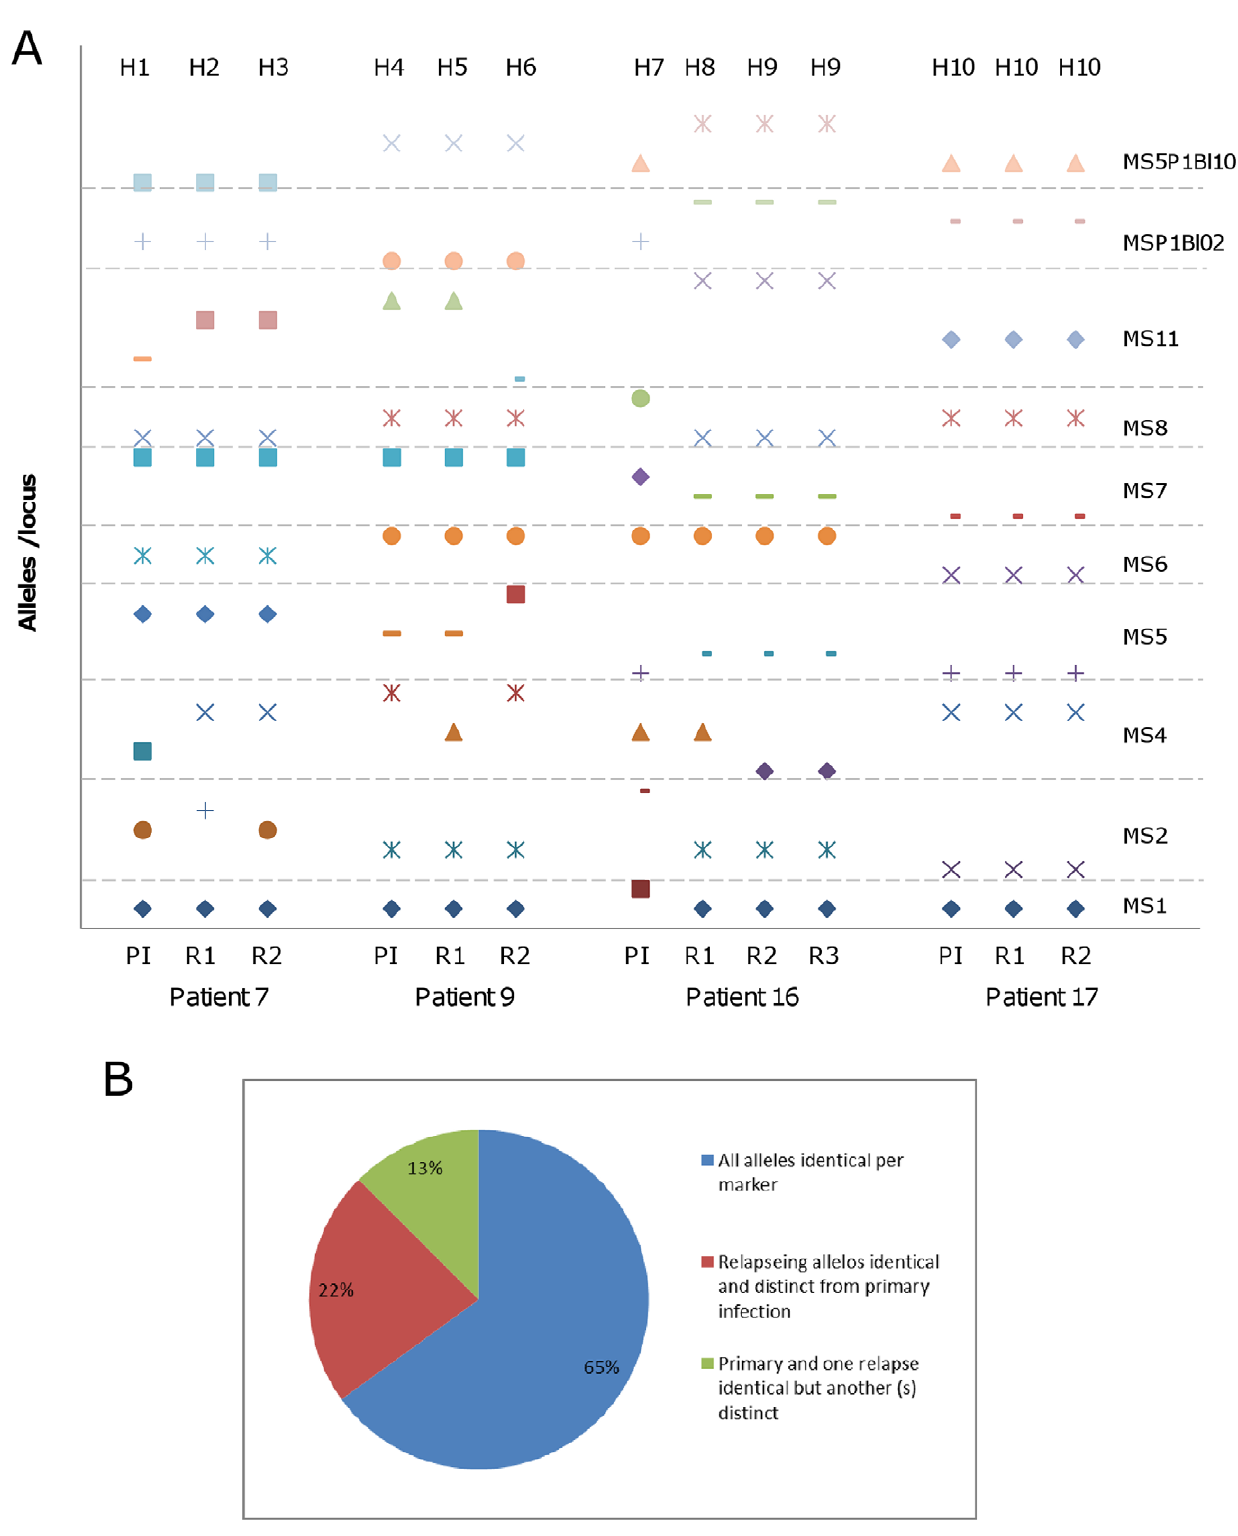
Figure 2. Temporal variation of the predominant alleles. (A) Comparison of predominant alleles among primary infection (PI), first relapse (R1), second relapse (R2), and third relapse (R3) from four P. vivax -infected patients genotyped using 10 molecular markers. Alleles are represented by different forms for each marker (indicated on the right side) and delimited by dotted lines. MS – microsatellite numbered according to Rezende et al. [36], MSP1bl2 and MSP1bl10– merozoite surface antigen 1 blocks 2 and 10, respectively. Haplotypes are indicated at the top of the Figure. (B) Frequencies of markers showing the same or distinct alleles at different times of blood collection for these four patients.